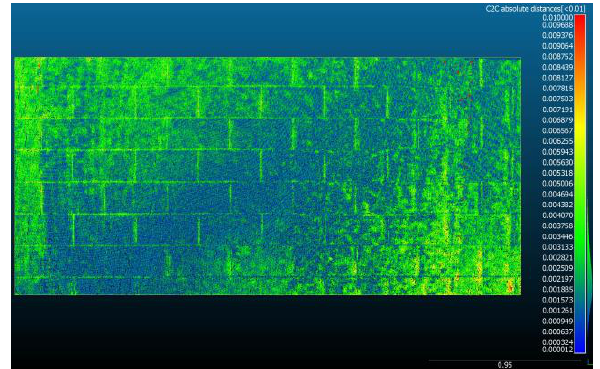
Figure 6. Comparison between a laser scan and the photogrammetric point cloud generated from central perspective images in the room with check points.